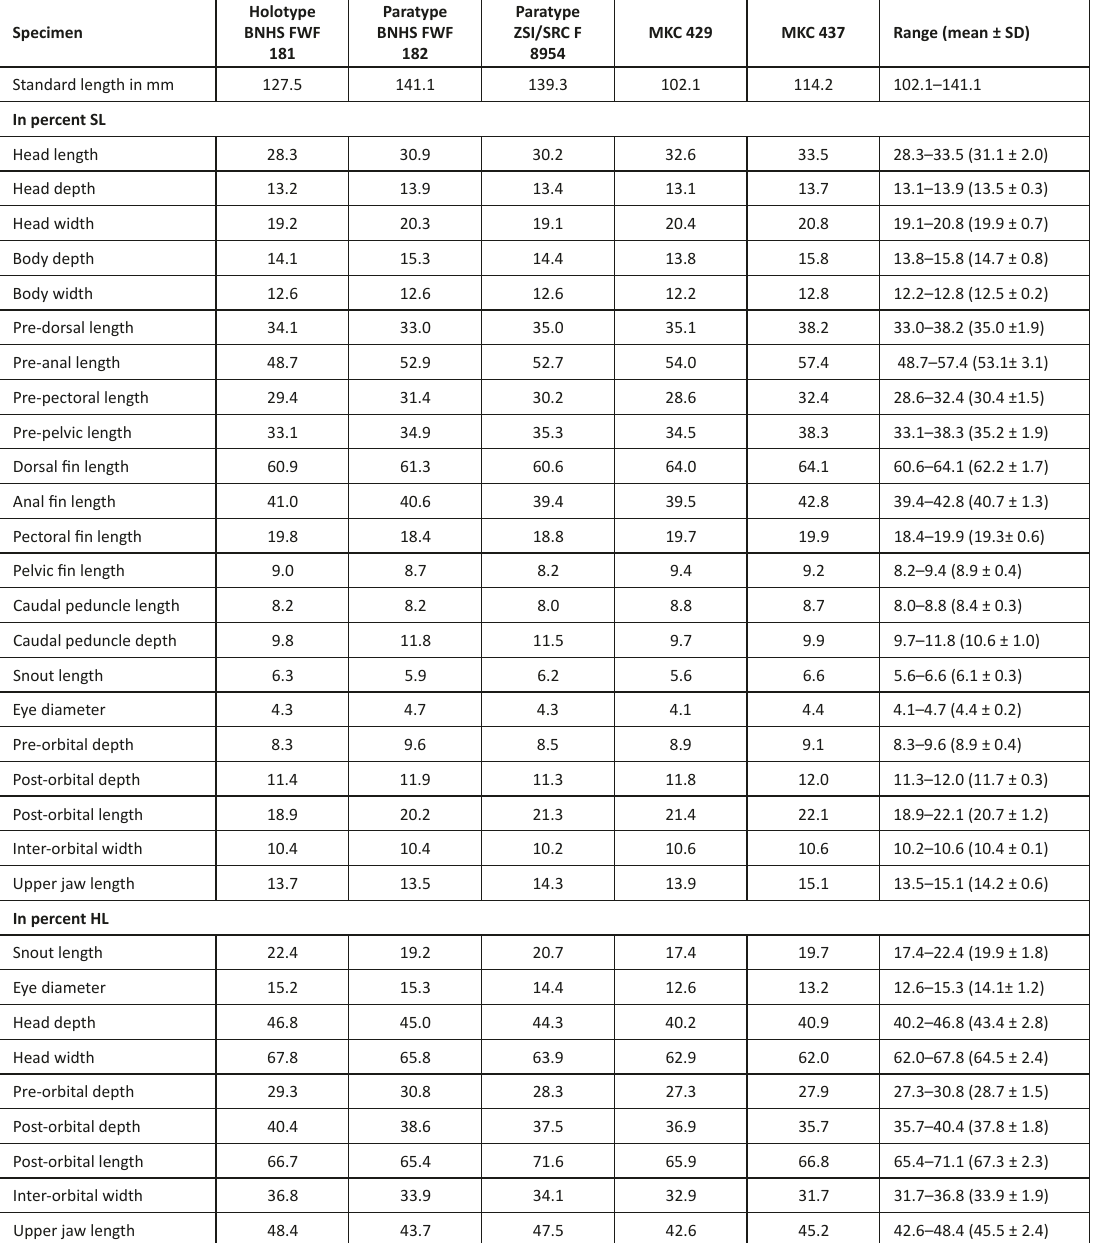
Table 1. Morphometric data of Channa pardalis sp. nov. (n = 5). Ranges include values of holotype. Holotype Specimen BNHS